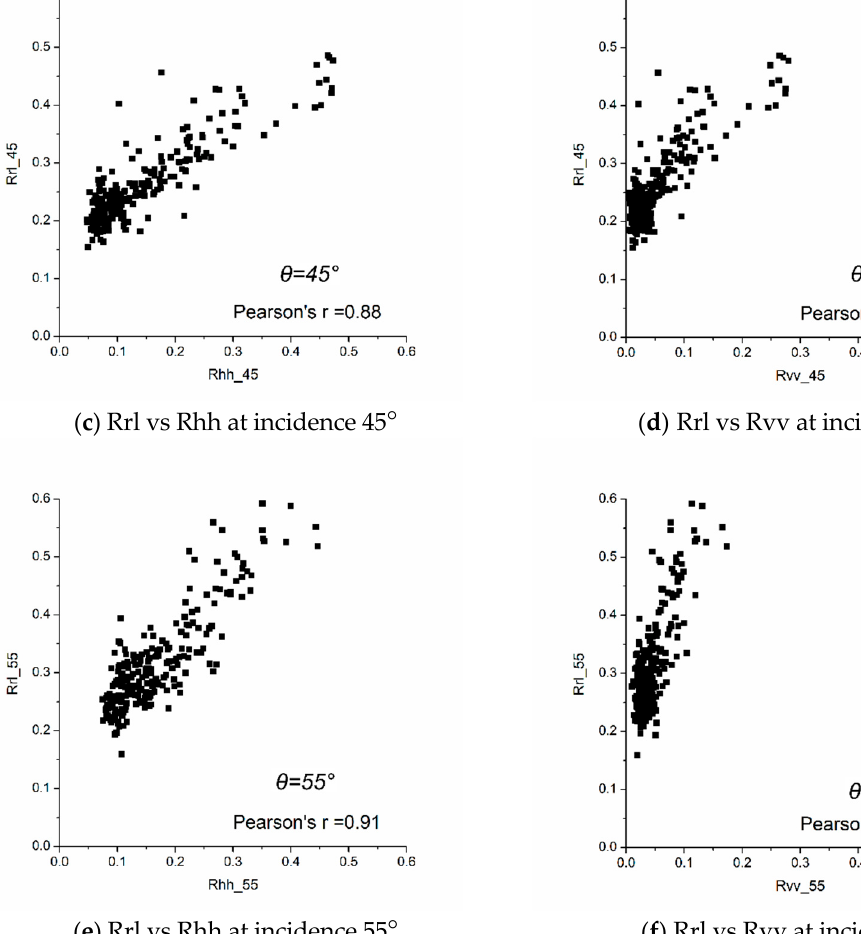
Figure 8. Correlation between GNSS LHCP reflectivity, Rrl, and ELBARA-II horizontal/vertical reflectivity, Rhh/Rvv, for three different incidence angles, namely 35°, 45°, and 55°, respectively, from top to bottom.